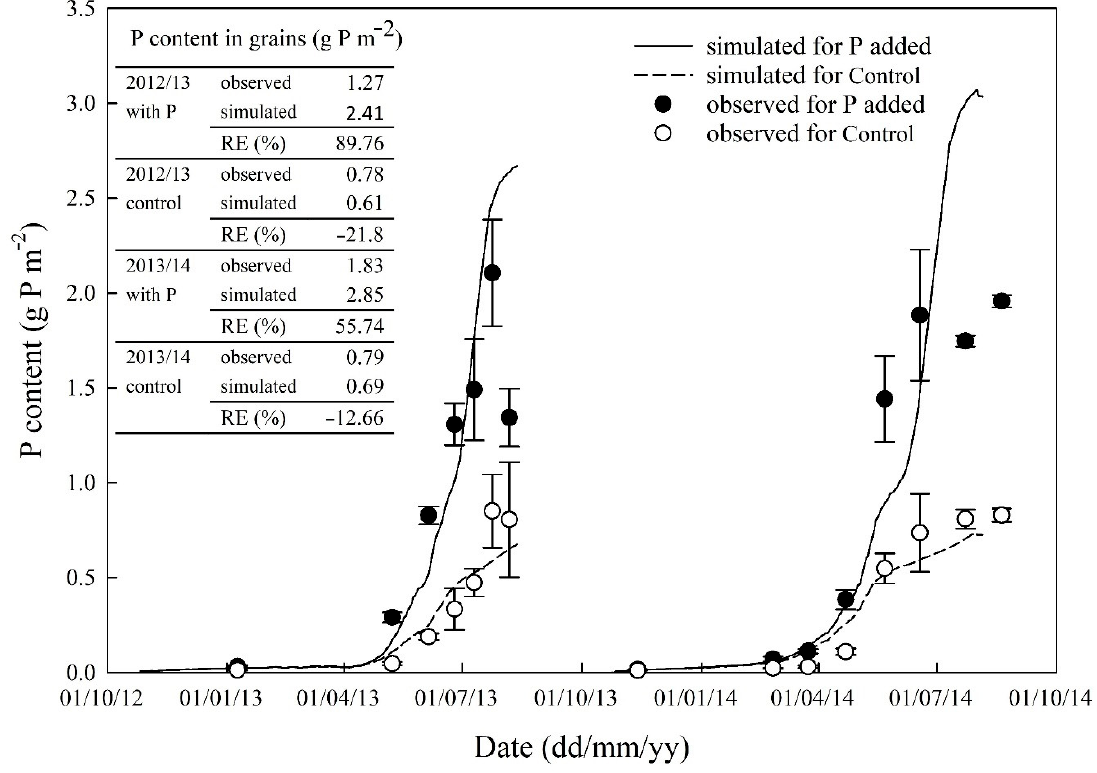
Figure 4. Simulated and observed (three replications) phosphorus content in aboveground dry matter and leaves. The error bars represent the standard deviation.